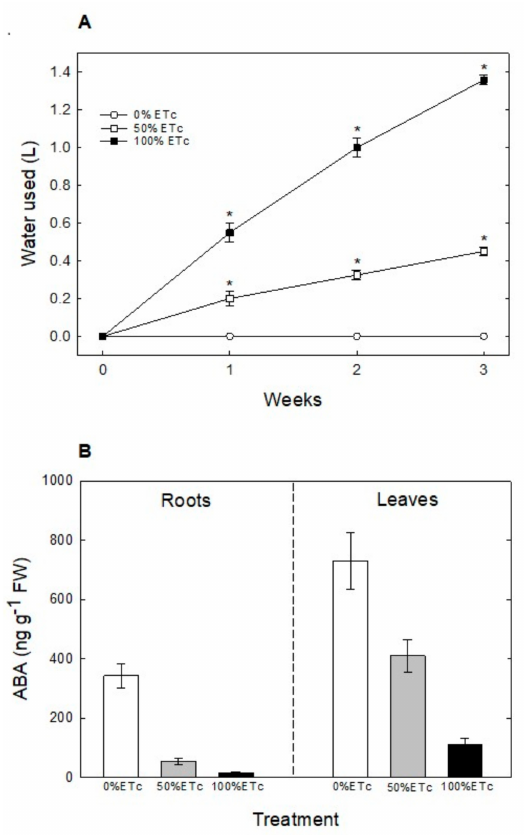
Figure 1. Water usage dynamics in response to three di ff erent water stress conditions: severe drought (0% evapotranspiration (ET)), mild drought (%50 ET), and fully watered plants (100% ET). ( A ) Average accumulated water used (accumulated evapotranspiration requirement, in liters) in each treatment during a 3-week period. Asterisks indicate significant di ff erences at * p < 0.05. ( B ) ABA concentration in roots and leaves of ‘Pineapple’ sweet orange trees at the end of the 3–week experiment in the di ff erent irrigation regimes